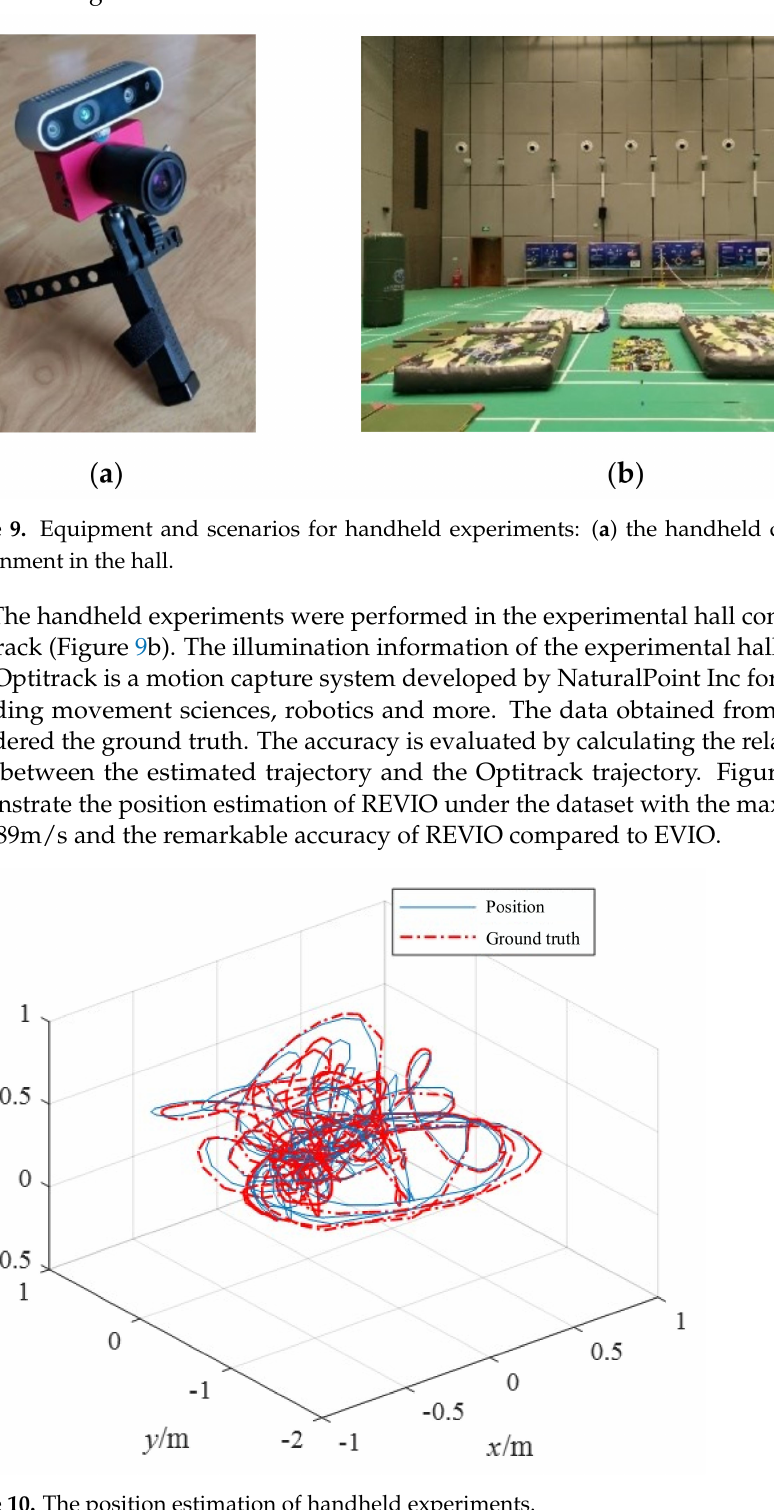
Figure 10. The position estimation of handheld